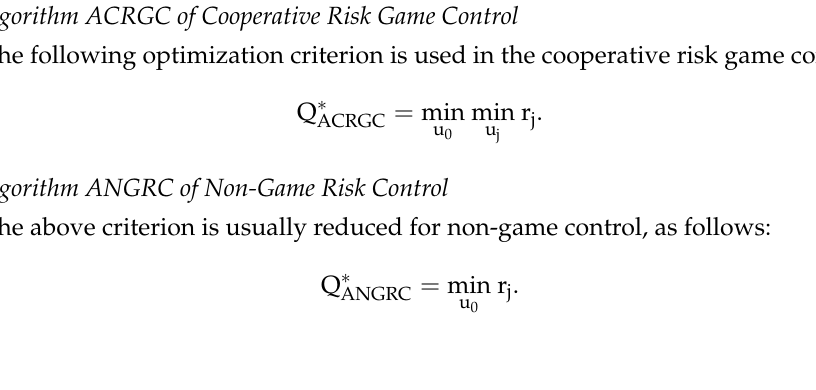
Figure 5. Algorithm flowchart of the positional game control for safe passing of ships.